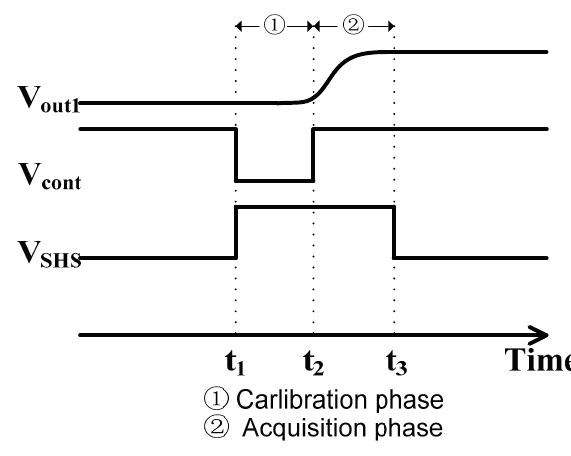
Figure 4. The timing diagram of the CDS